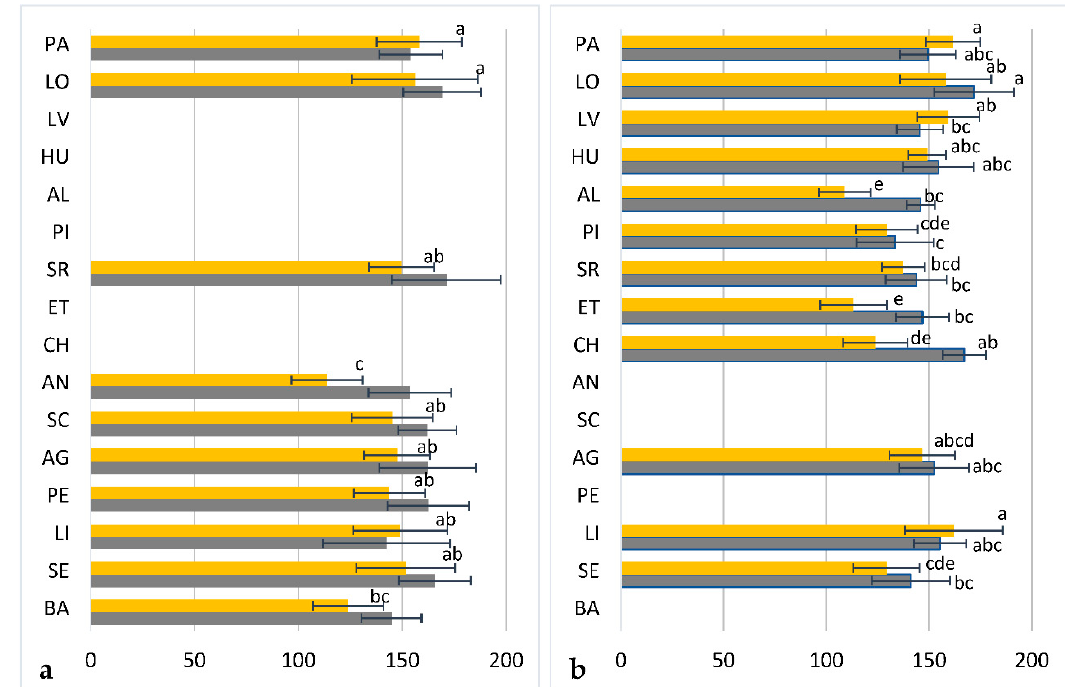
Figure 3. Mean total phenols (mg GAE/dr wt, grey bars) and arbutin (mg/g dr wt, yellow bars) contents of leaf extracts from bearberry plants collected in 2014 ( a ) and 2015 ( b ) in 16 natural populations of Spain located in a wide range of altitude, from 424 (BA) to 1410 m a. s. l. (PA). For each location, data are mean and standard deviation of eight plants analyzed in triplicate (except for HU, N = 6). Within each set of data, values followed by the same letter were not different according to Tukey test.